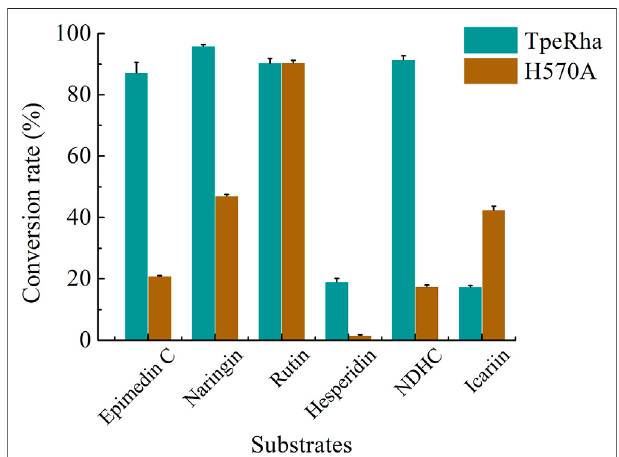
FIGURE 5 | The conversion rates of TpeRha and H570A reacted with different substrates. The conversion rates of epimedin C, naringin, hesperidin, and NDHC for TpeRha were higher than that for H570A. The conversion rates of the substrate rutin for both were comparable. The conversion rate of icariin for H570A was 2.45 times higher than that for TpeRha.